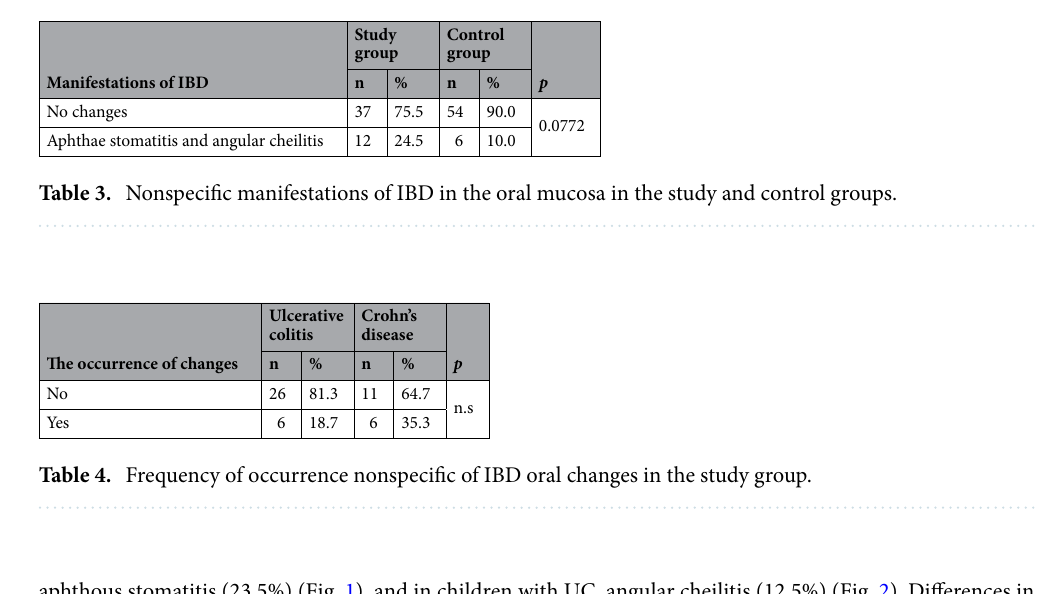
Manifestations of IBD